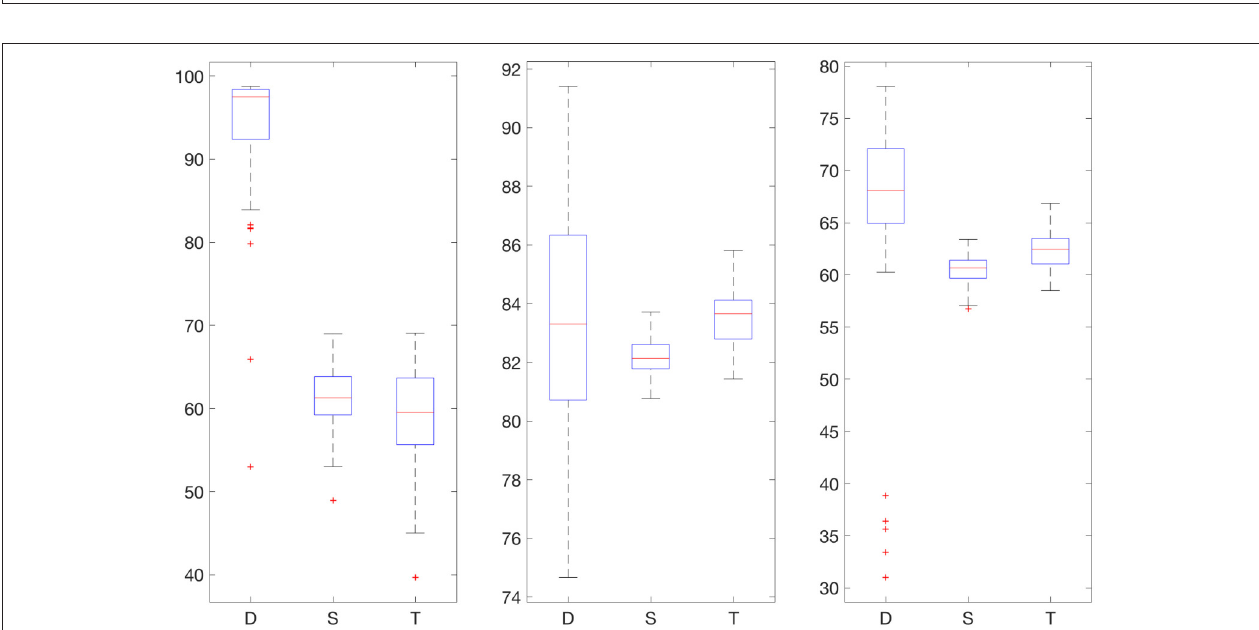
FIGURE 4 | Boxplot for the 100 experiments conducted with flat low-pass filtering and 30% training data for each prediction method (D, deep network; S, shallow network; T, Tikhonov regularization). The three graphs show the percentage accurate predictions in the hypoglycemic range (left), euglycemic range (middle) and hyperglycemic range (right).